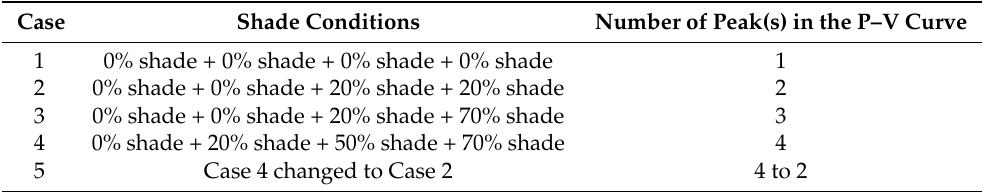
Table 2. Shade conditions in the four selected test cases.